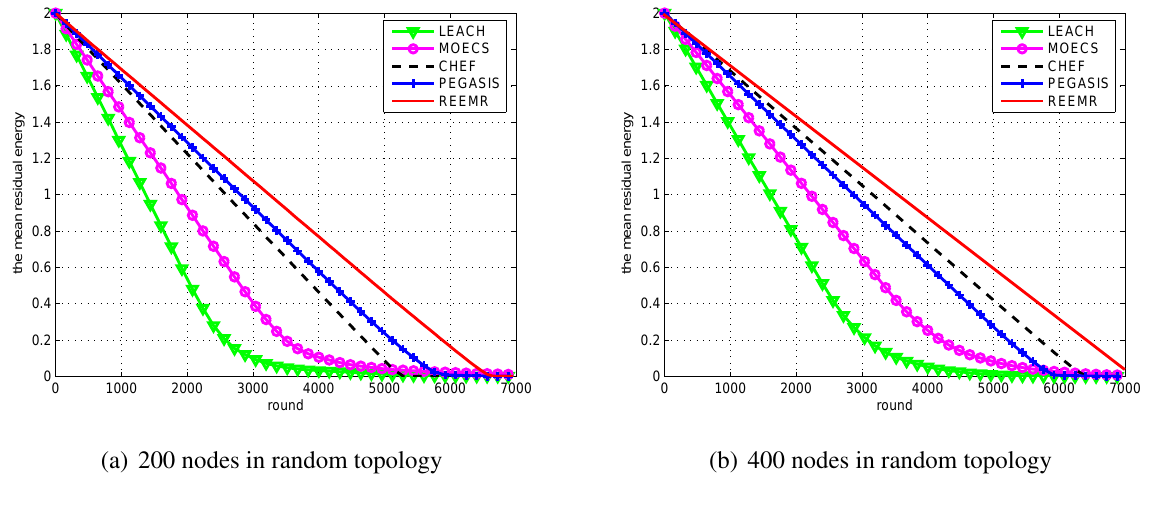
Figure 13. Mean residual energy of LEACH, MOECS, CHEF, PEGASIS, and